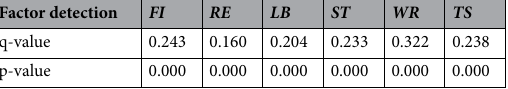
Table 4. Factor detection results.